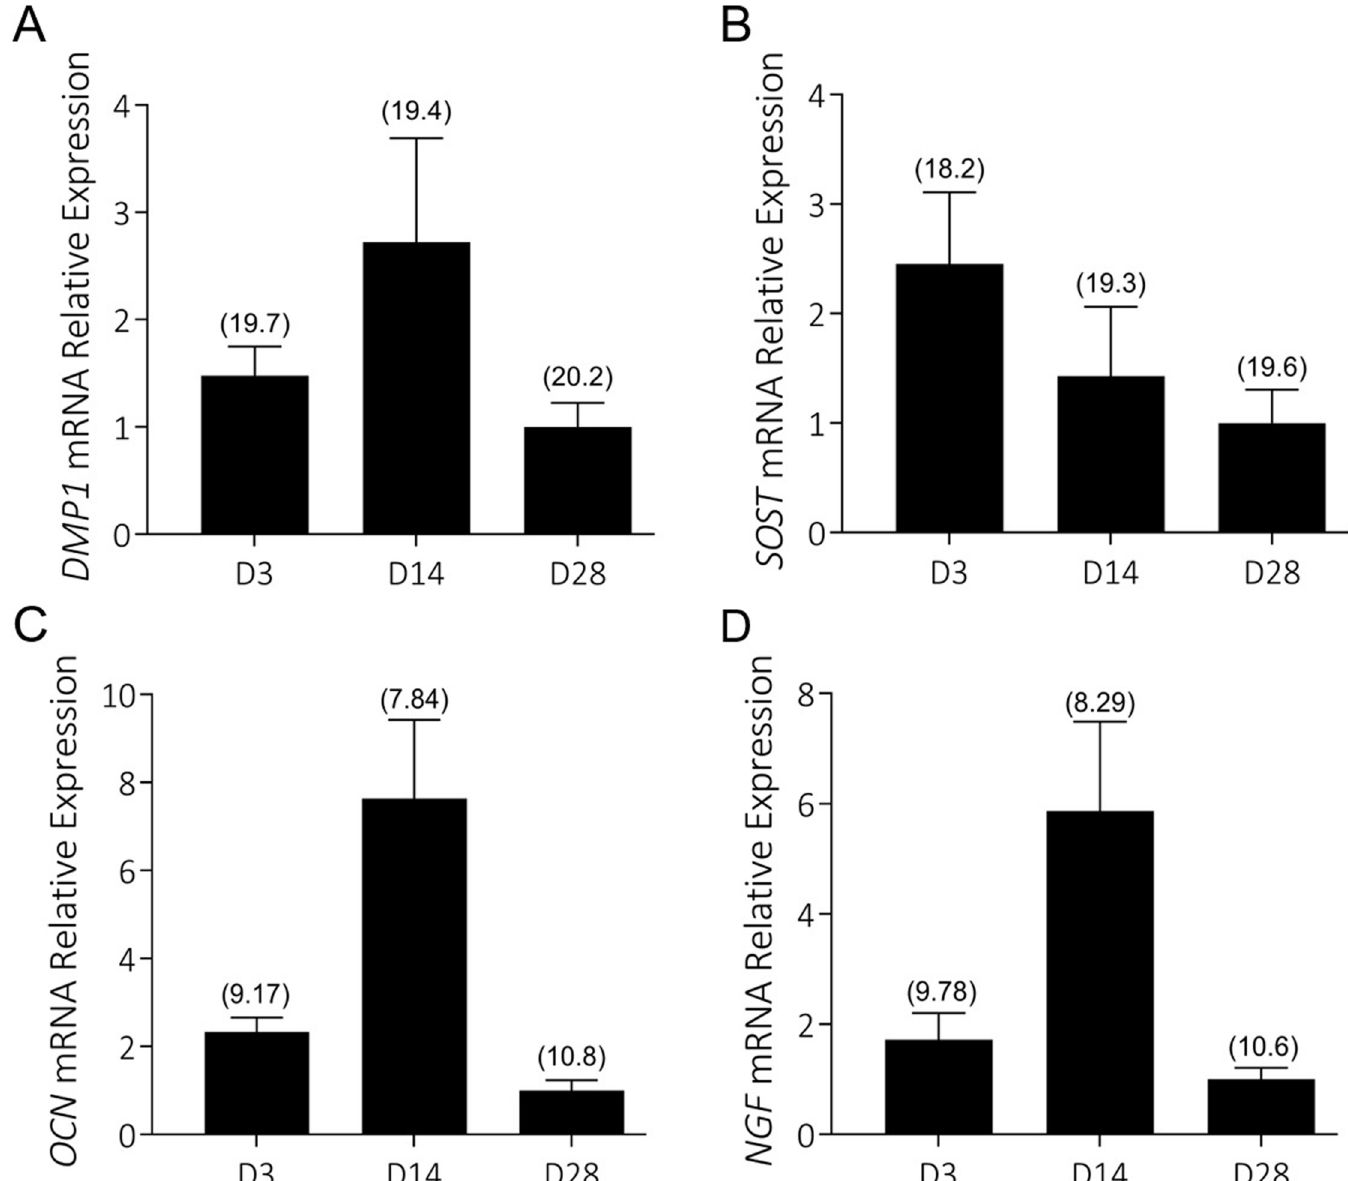
Fig 1. Human differentiating KOA osteoblast/osteocyte cultures express NGF: Cells from 3 KOA patients were cultured under pro-osteogenic conditions for up to 28d, as described in Materials and Methods. Gene expression was measured by real-time RT-PCR at various timepoints for: A) DMP1 ; B) SOST ; C) OCN ; D) NGF . Data (means + standard error of the mean (SEM)) were normalised to the expression of 18S rRNA using the 2 -( Δ CT) method and are shown relative to the expression of each gene at the end of the time course pooled from 3 donors’ cells. The mean Δ CT for each timepoint is indicated in parentheses above each histogram.